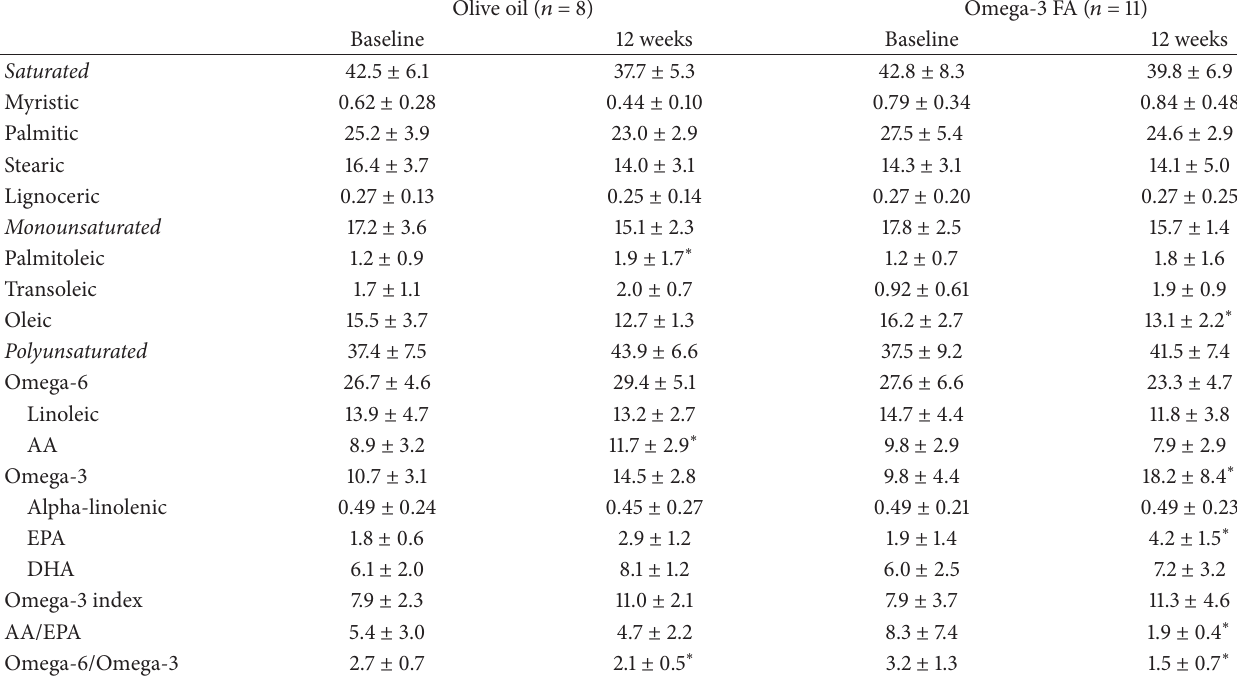
Table 5: Changes in erythrocyte membrane fatty acids